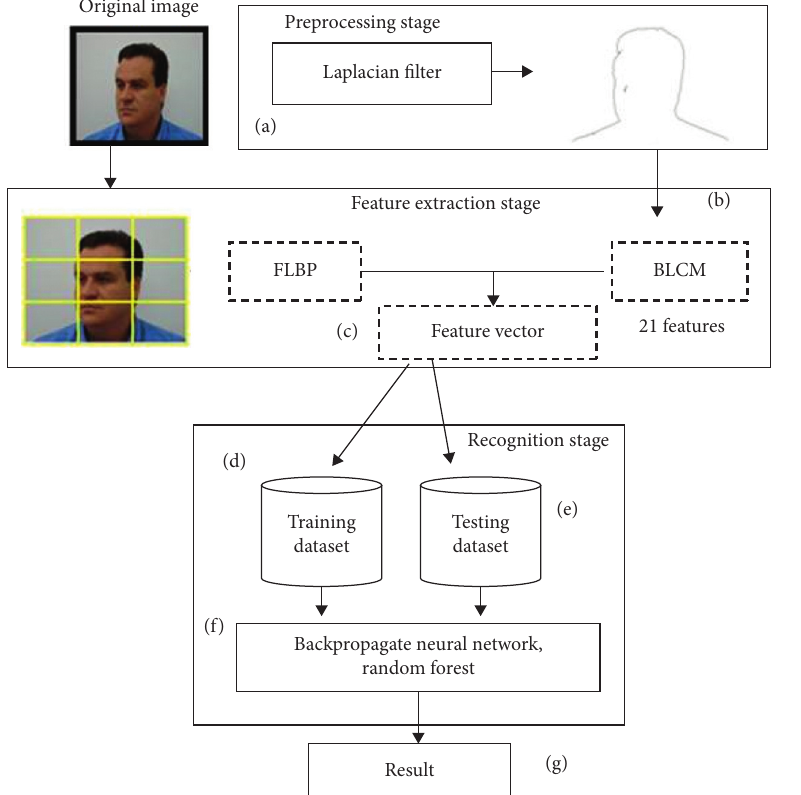
Figure 2: Designed flowchart of the novel model.